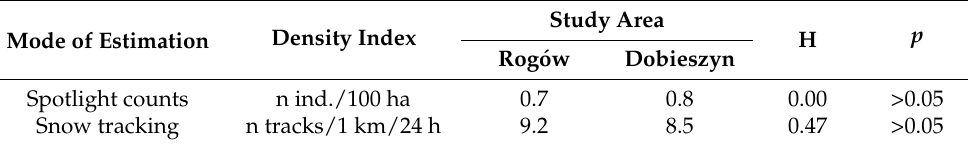
Table 2. Comparison of red fox density indices between the study area (Rog ó w) and a reference area placed in central Poland (Dobieszyn), in the past decades (Table S1). Values of Kruskal–Wallis test (H) and p -values are given.